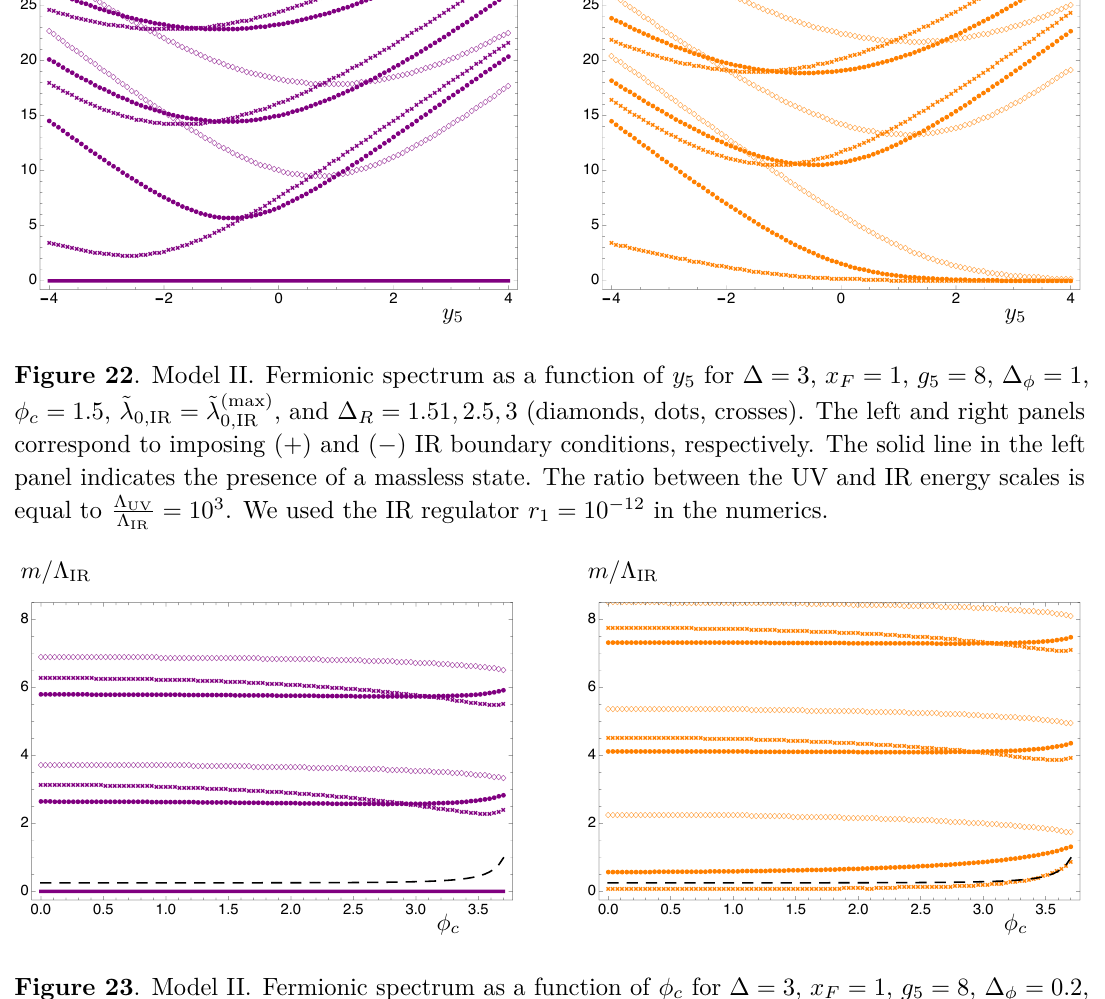
Figure 23 . Model II. Fermionic spectrum as a function of φ c for ∆ = 3 , x F = 1 , g 5 = 8 , ∆ φ = 0 . 2 , y 5 = 0 , ˜ λ 0 , IR = ˜ λ (max) , and ∆ R = 1 . 6 , 2 . 5 , 3 (diamonds, dots, crosses). The maximum allowed value 0 , IR p of φ c is given by 3 / ∆ φ ≈ 3 . 87 . The decay constant ˜ f is represented by the dashed black line. The left and right panels correspond to imposing (+) and ( − ) IR boundary conditions, respectively. The solid line in the left panel indicates the presence of a massless state. The ratio between the UV and IR energy scales is equal to Λ UV = 10 3 . We used the IR regulator r 1 = 10 − 12 in the Λ IR